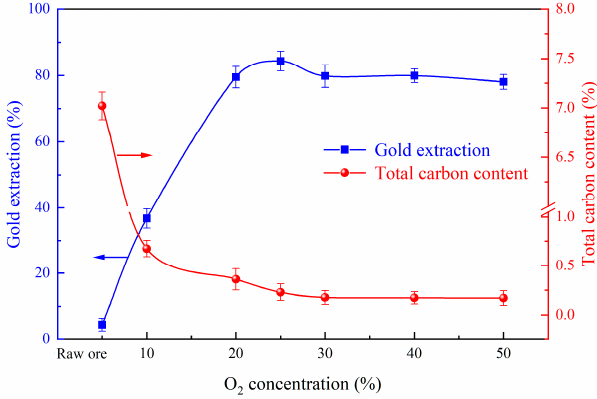
Figure 7. The effect of O 2 concentration on gold extraction.